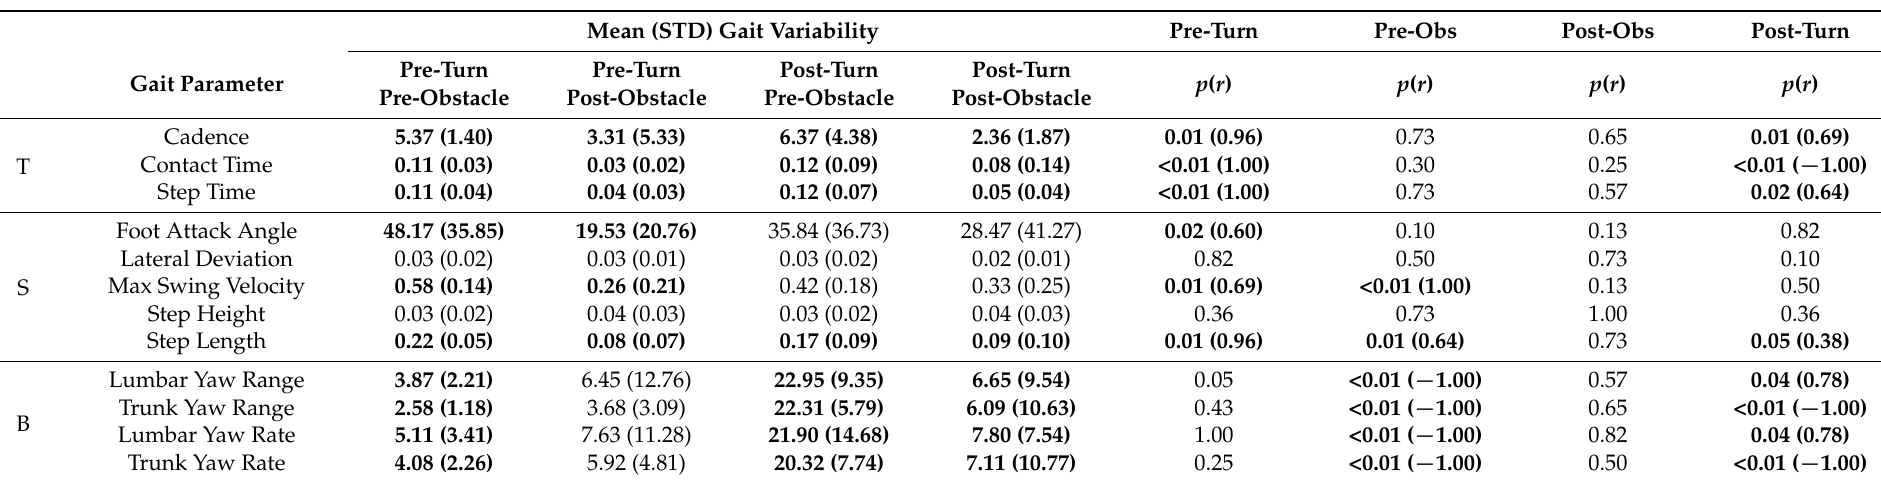
Table 4. Comparisons of gait variability during phases of the walk and turn with obstacle task for PwMS. p -values ( p ) are reported for each comparison with effect sizes ( r ) indicated for significant differences. Comparisons: Pre-turn pre-obstacle to pre-turn post obstacle (pre-turn), pre-turn pre-obstacle to post-turn pre-obstacle (pre-obs), pre-turn post-obstacle to post-turn post-obstacle (post-obs), and post-turn pre-obstacle to post-turn post-obstacle (post-turn).